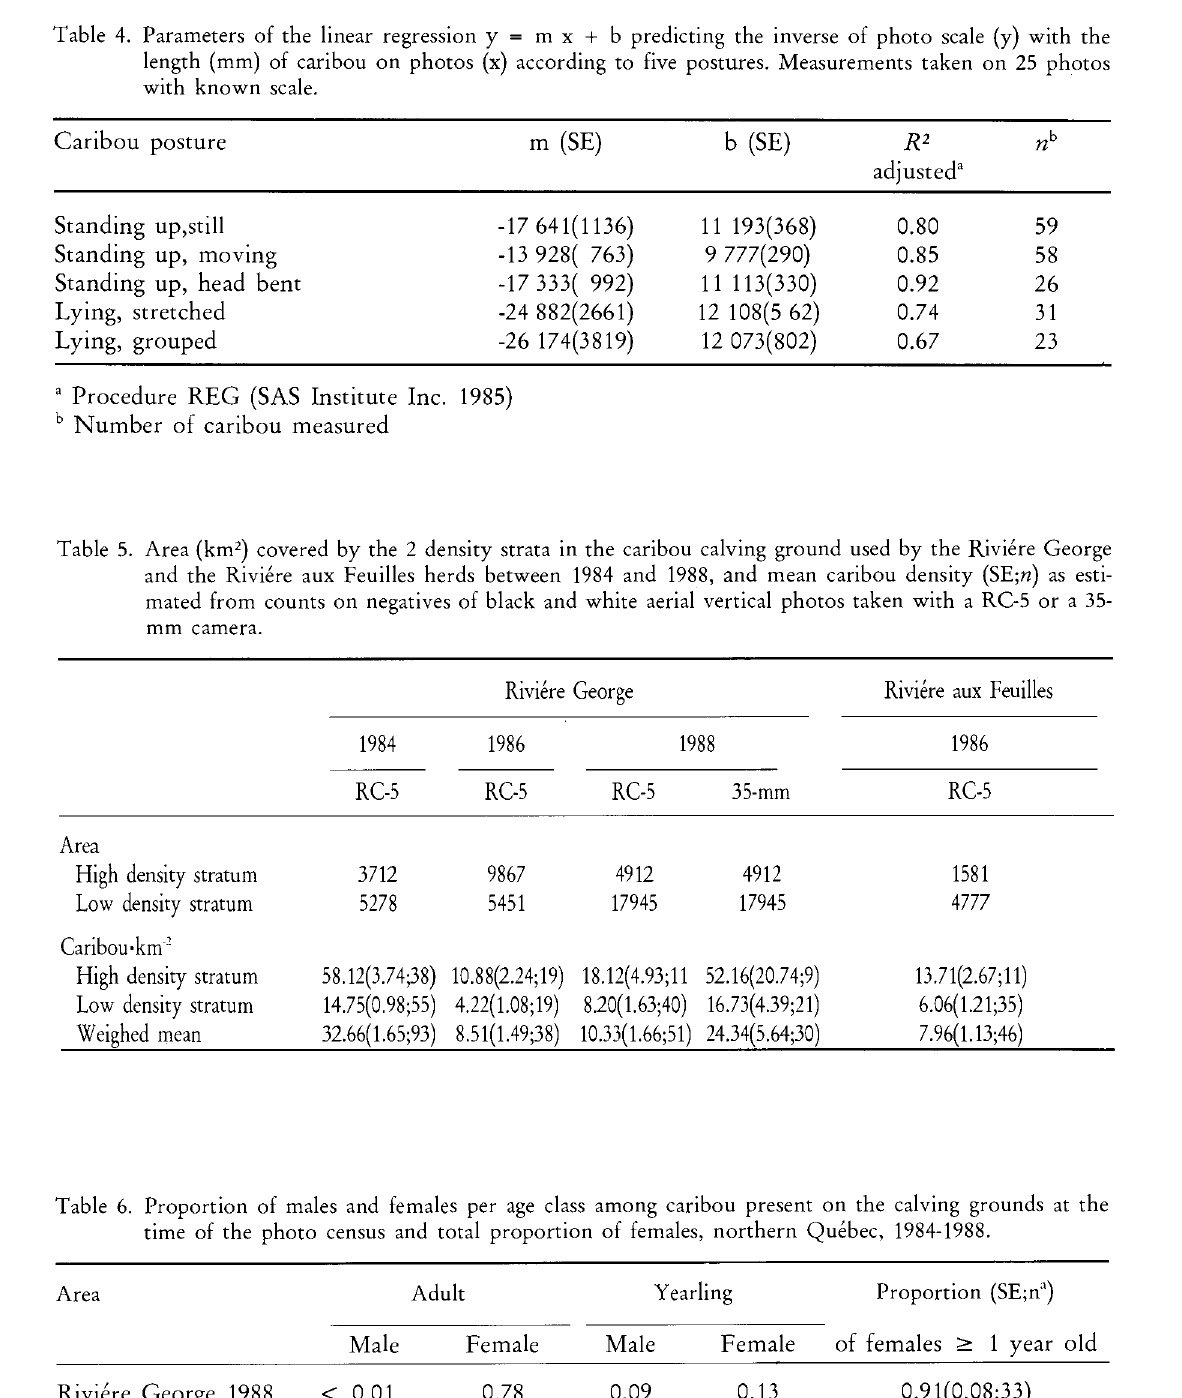
Table 4. Parameters of the linear regression y = m x + b predicting the inverse of photo scale (y) with the length (mm) of caribou on photos (x) according to five postures. Measurements taken on 25 photos with known scale.